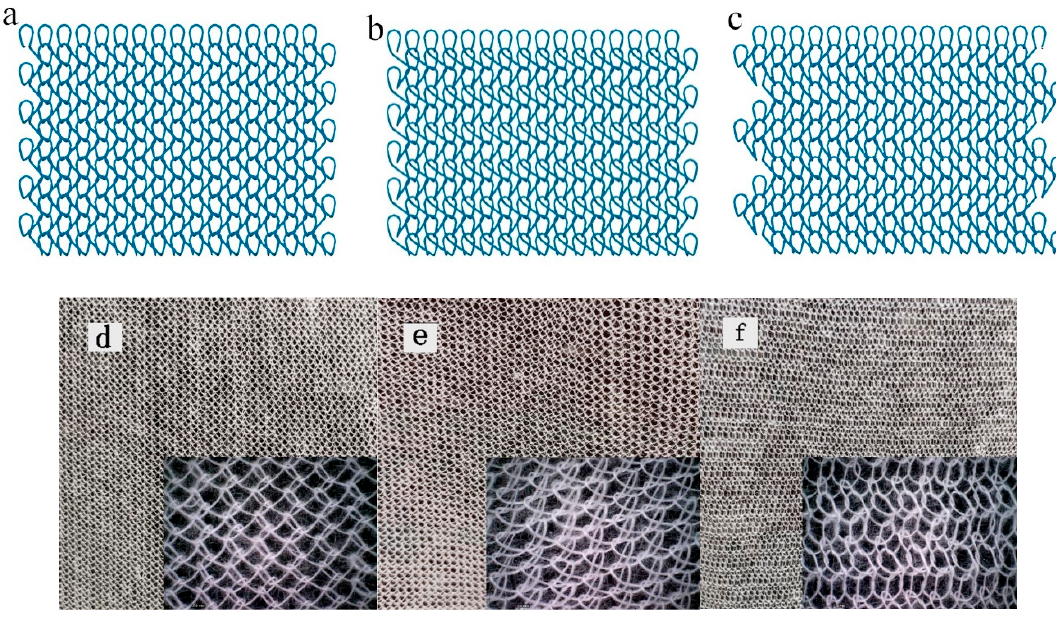
Figure 1. Structure of three fabrics: No. 1 ( a , d ), No. 2 ( b , e ), and No. 3 ( c , f ).